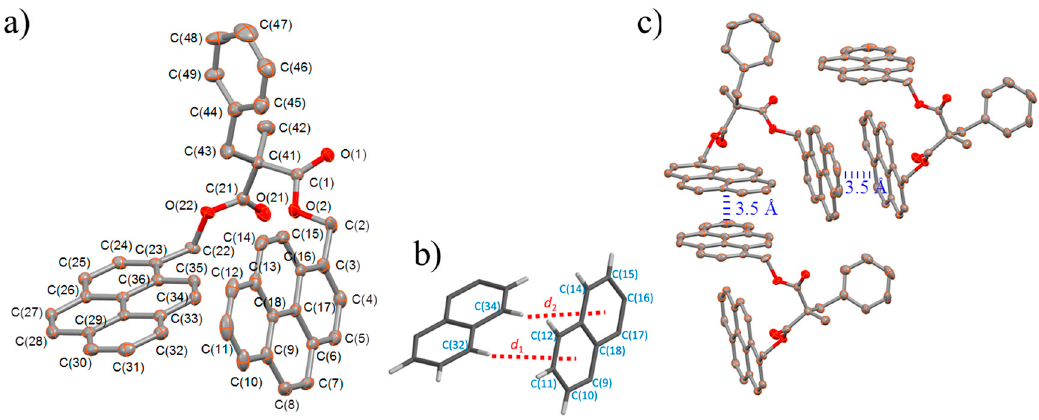
Figure 2. ( a ) Molecular structure; ( b ) schematic representation of the intramolecular C–H··· π interactions and ( c ) alignment of bispyrenyl malonate 1 determined by X-ray crystallographic analysis (40% probability of thermal ellipsoid plots).